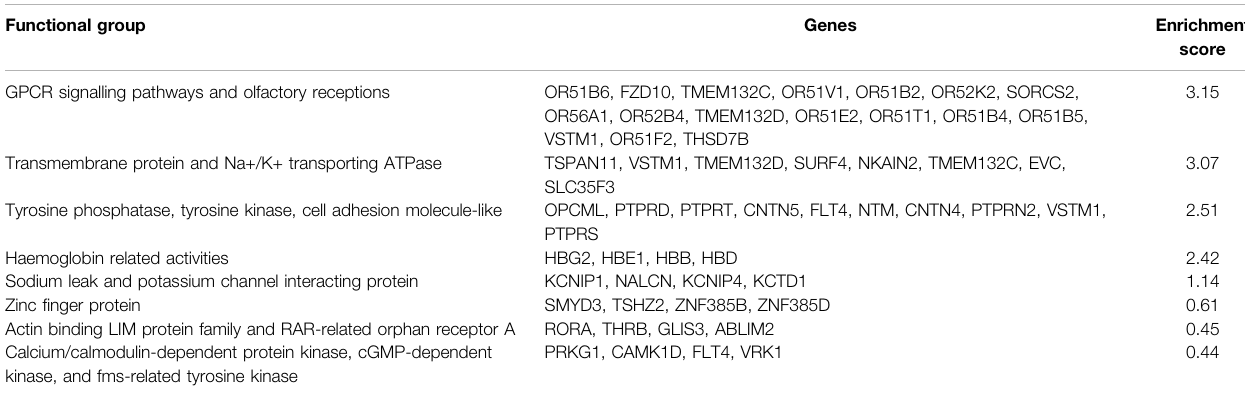
TABLE 3 | Functional categories of genes identi fi ed by gene-based GWAS analysis grouped using DAVID method. Functional